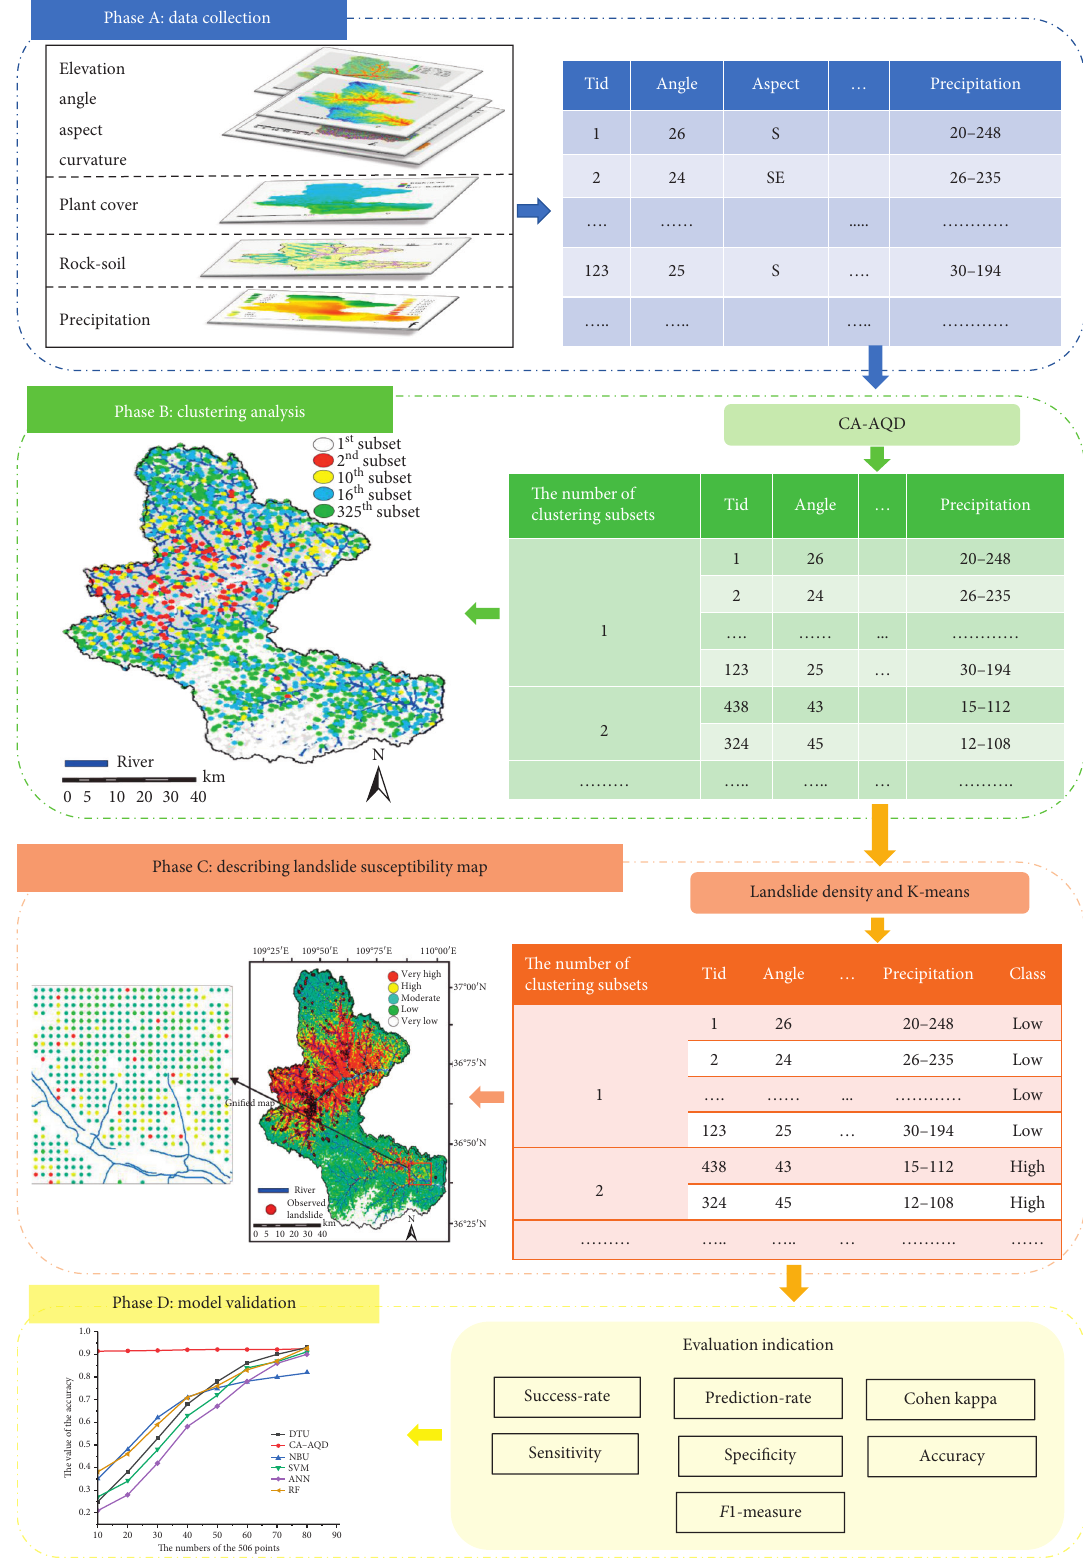
Figure 6: The overall workflow of mapping landslide